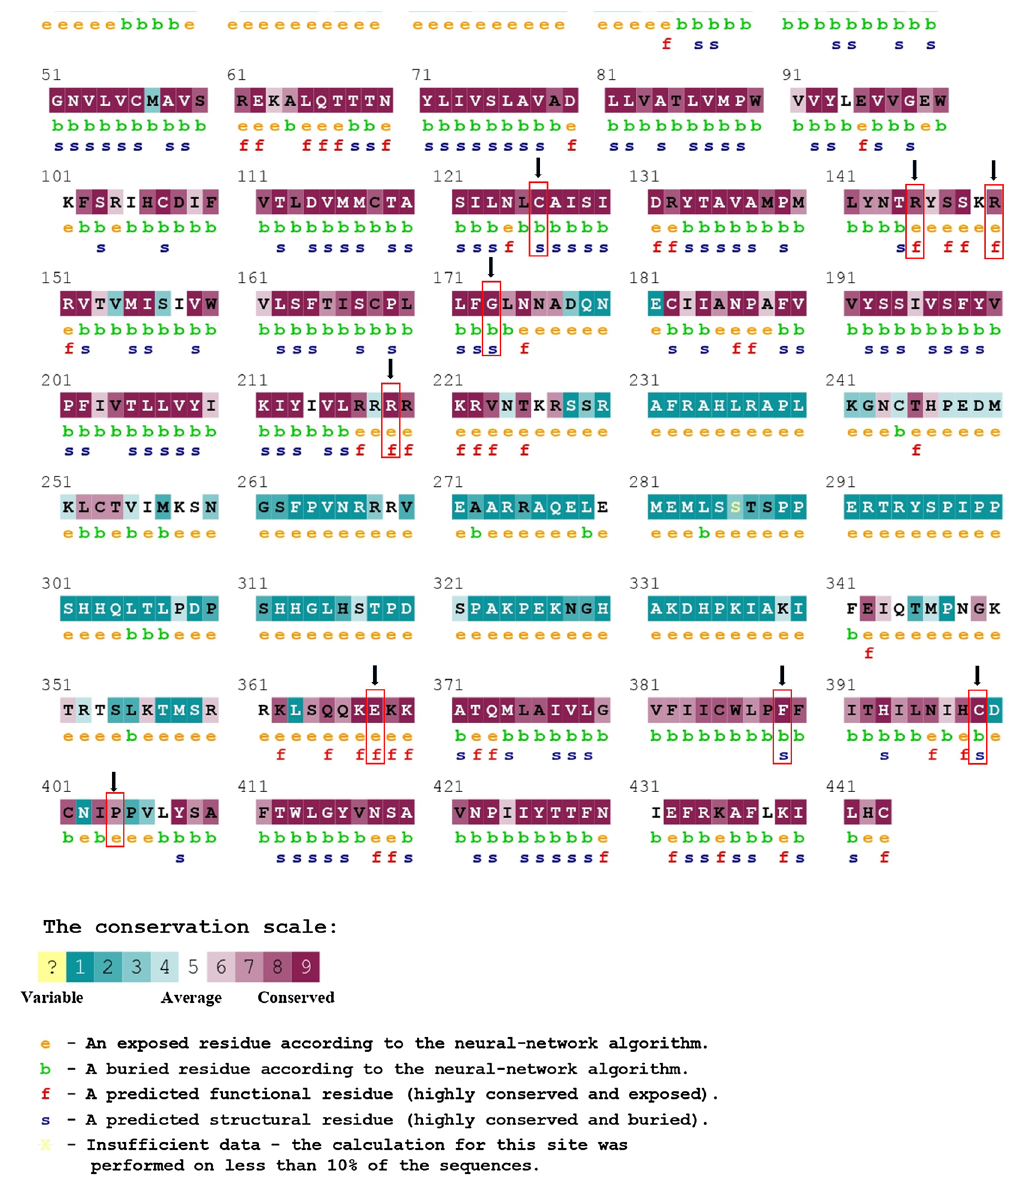
Figure 3. Evolutionary conservation profile of amino acid residues of DRD2 as predicted by ConSurf. Almost all the nsSNPs primarily evaluated as deleterious belonged to the highly conserved